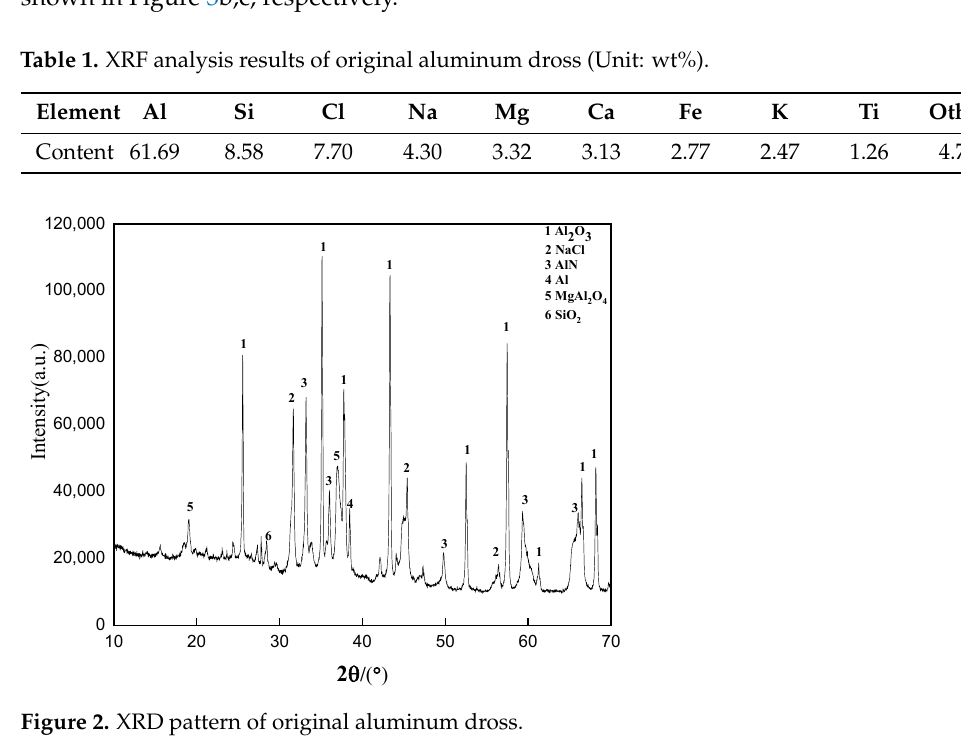
( c ) Figure 3. SEM-EDS image of original aluminum dross. ( a ) SEM of original aluminum dross; ( b ) SEM and micro-area element surface distribution of the red frame area; ( c ) EDS spectrum analysis of the red frame area. The acid-base constant volume method is used to determine the AlN content in the original recycled aluminum dross. With alumina as the blank control group, the results are shown in Table 2.